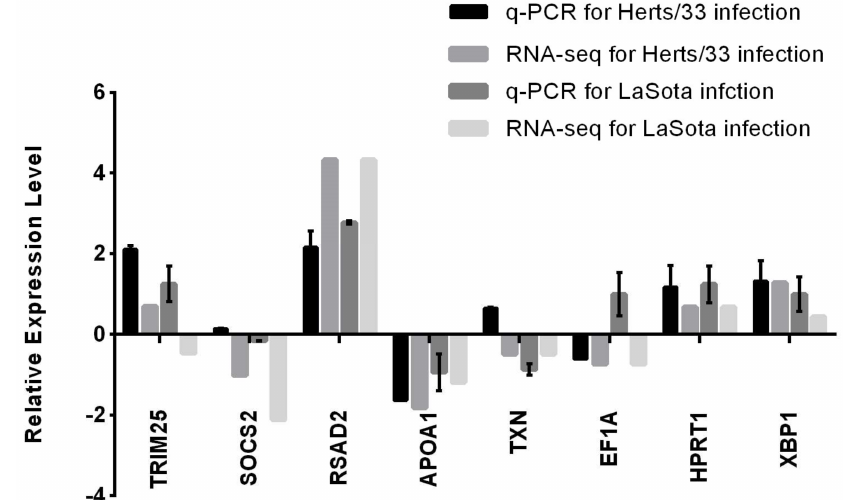
Figure 6. Verification of the relative expression levels quantitative real-time PCR (qPCR). Expression patterns of selected differentially expressed genes associated with NDV infection as determined by qPCR. The x-axis shows the annotations of the selected genes. The y-axis shows expression levels that are normalized to GAPDH